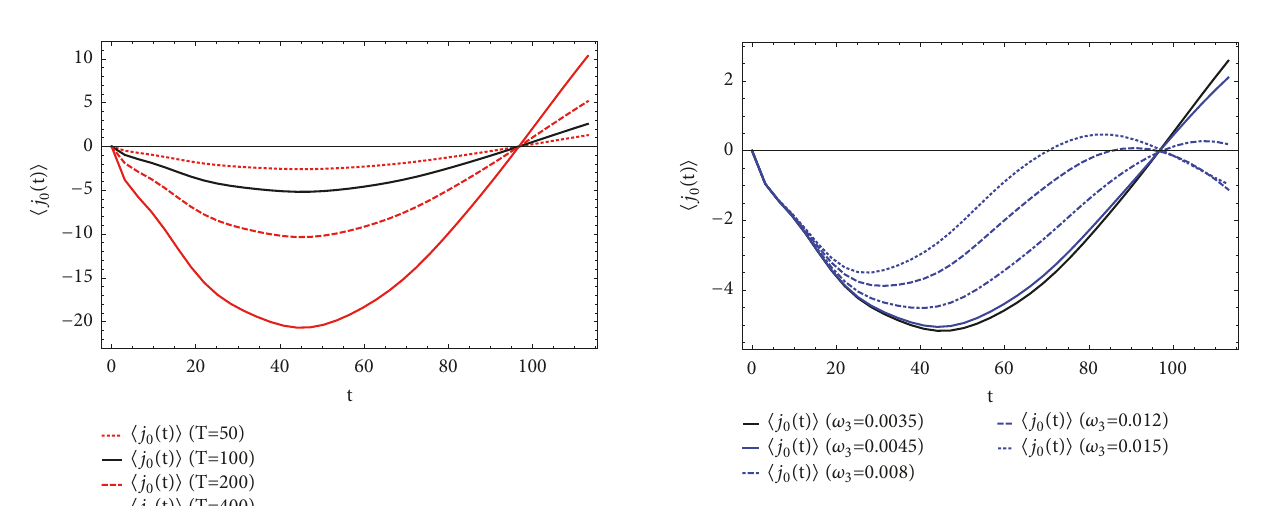
Figure 3: The 𝜔 3, 0 dependence of the time evolution of PNA. In horizontal axis, we use the dimensionless time 𝑡 = 𝜔 푟 3, 0 (𝑥 0 − 𝑡 0 ) where we choose 𝜔 푟 3, 0 = 0.35 . We use a set of parameters as ( ̃𝑚 1 , ̃𝑚 2 , 𝐵,𝑇,𝐻 푡 ) = ( 0.04,0.05,0.021,100,10 −3 ) for all of the lines. 0 The black, blue, dot-dashed blue, dashed blue and dotted blue lines show the cases 𝜔 3, 0 = 0.0035,0.0045,0.008,0.012 and 0.015 , respectively.